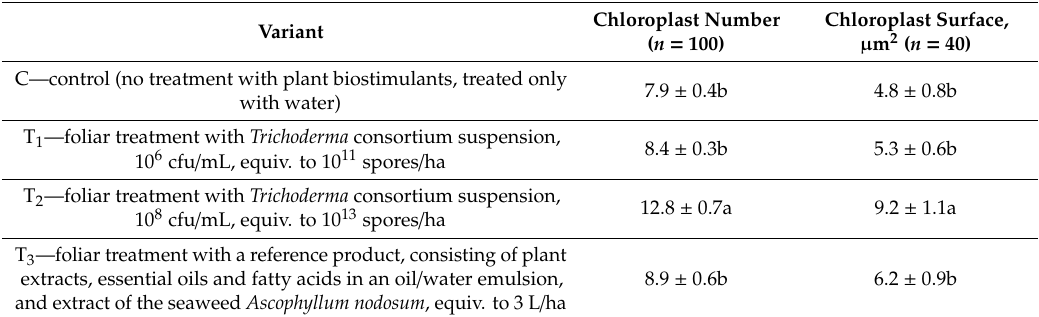
Table 1. Number and surface (in µ m 2 ) of the chloroplasts from spongy parenchyma of P. caerulea plants treated with plant